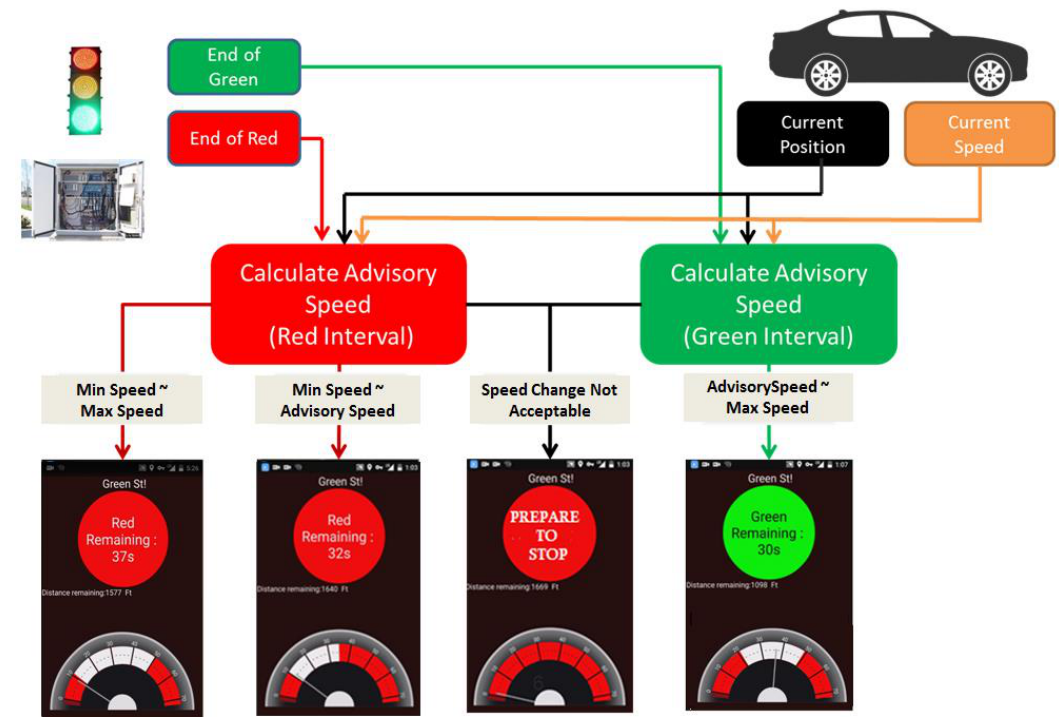
Figure 4. ITSAS speed guidance cases.